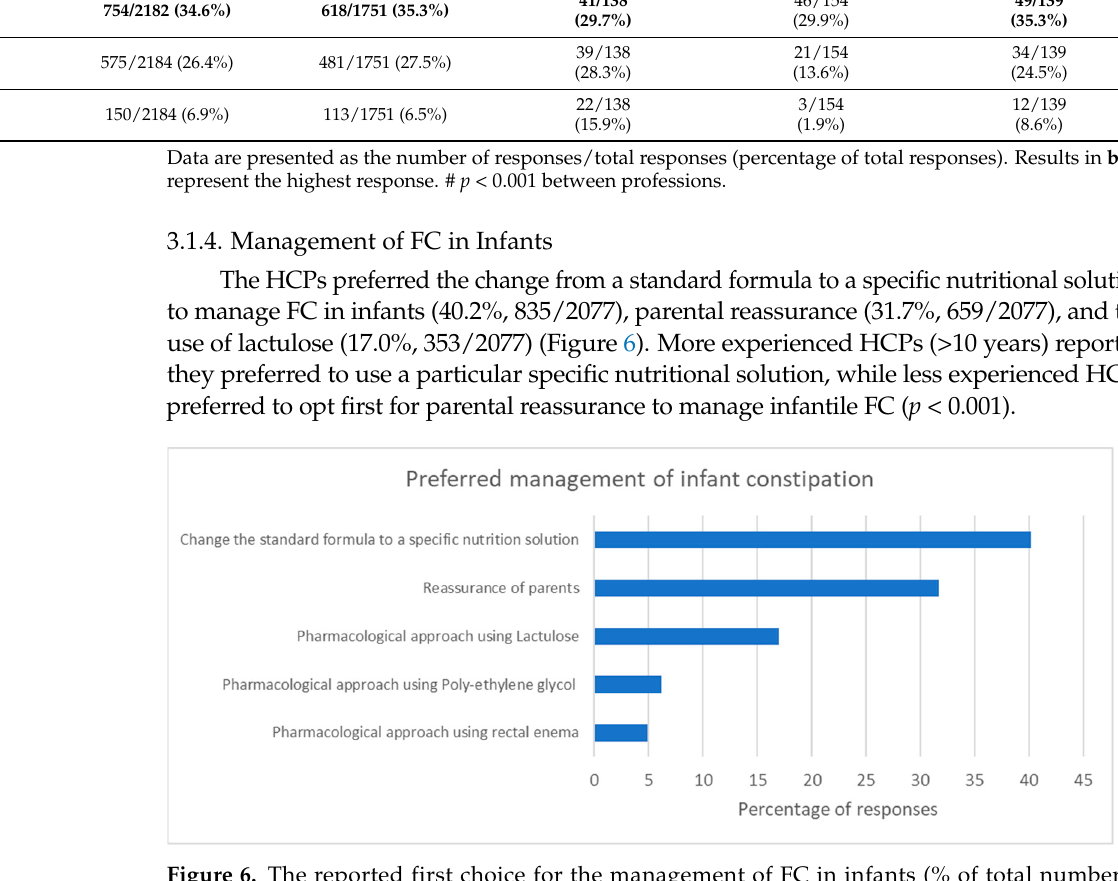
Figure 6. The reported first choice for the management of FC in infants (% of total number of re- spondents).